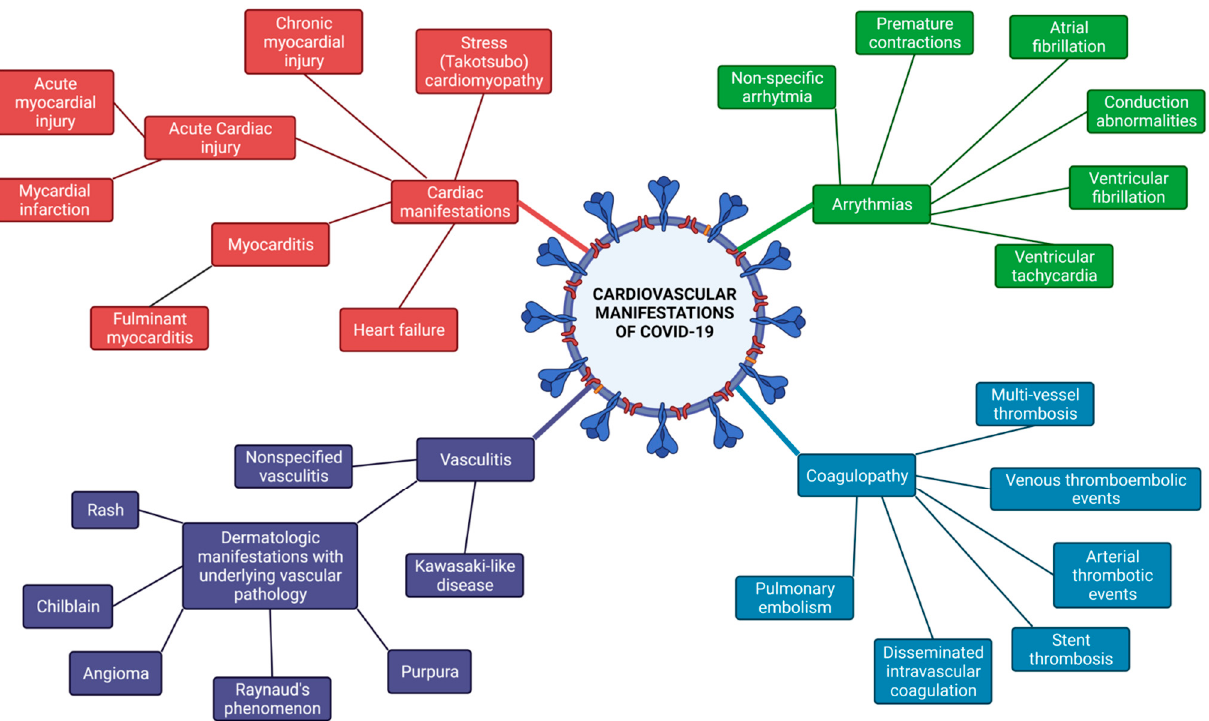
Figure 2. Schematic representation of COVID-19 related cardiovascular manifestations. Created in Biorender.com (accessed on 6 November 2021).